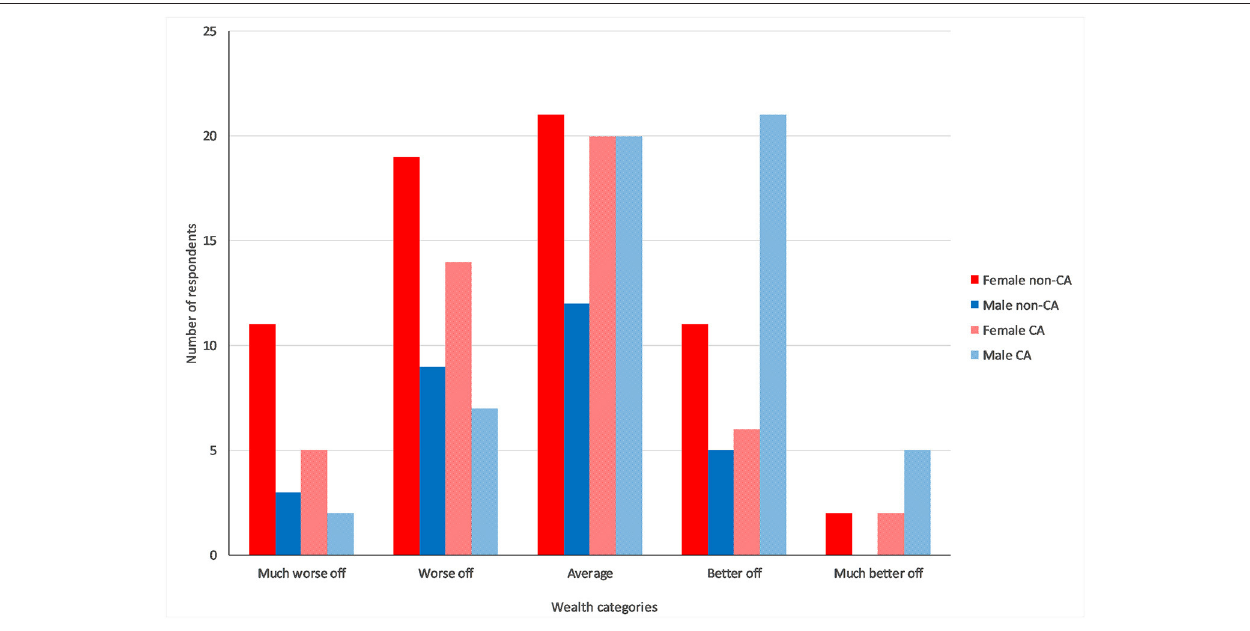
FIGURE 3 | Wealth and gender by farming type (Household survey, n = 201).